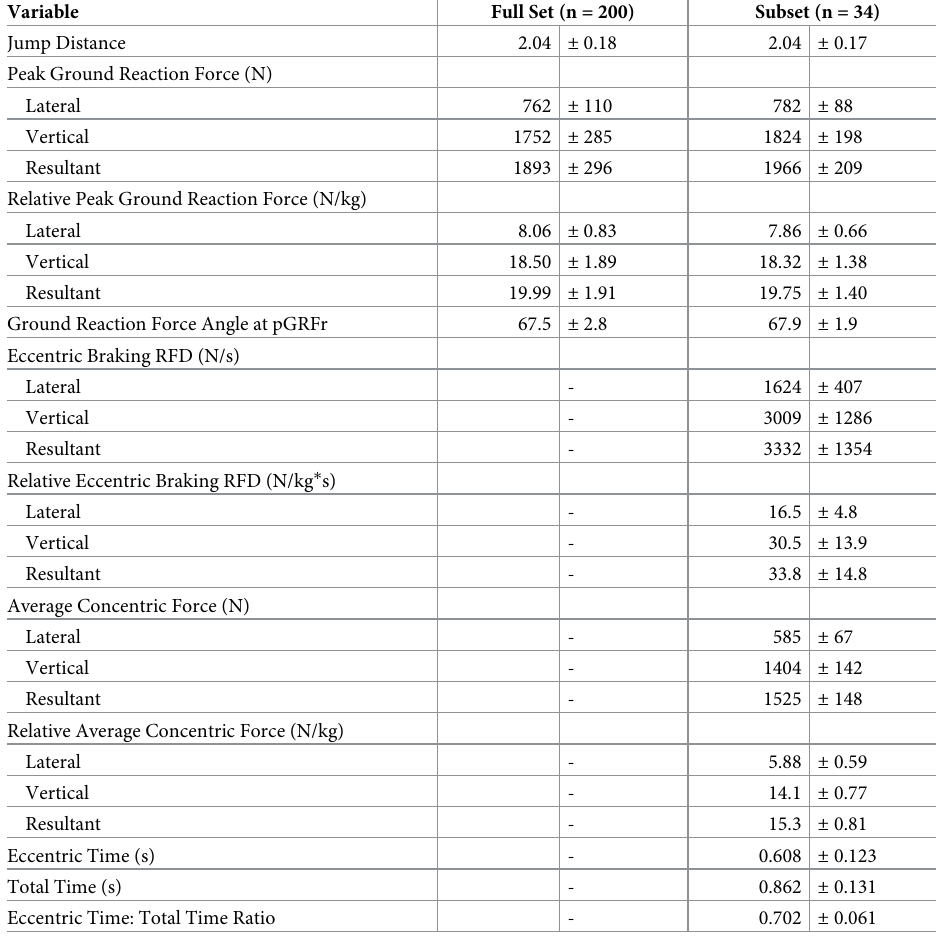
Table 1. Descriptive statistics (mean ± standard deviations) for the full trial set and trial